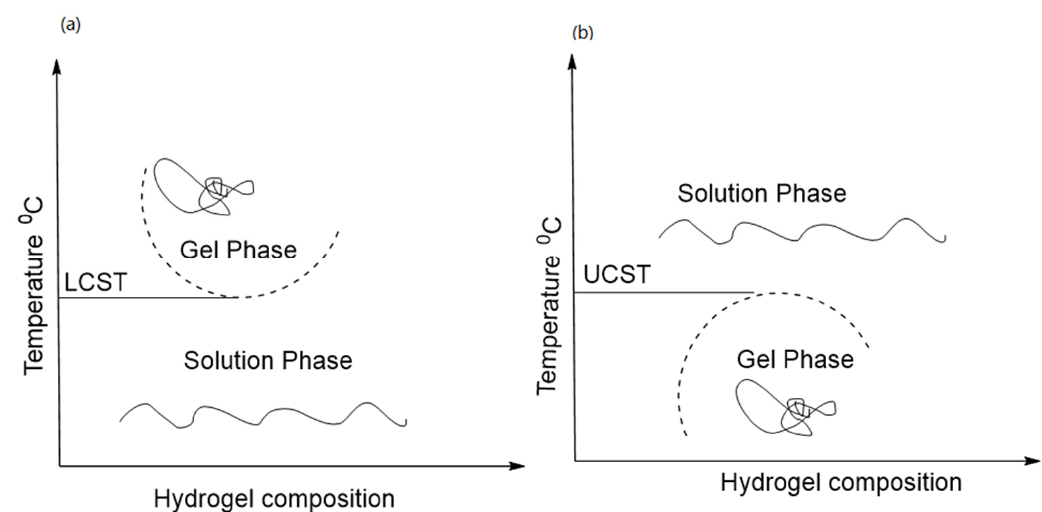
Figure 2. ( a ) the lower critical solution temperature (LCST) formed hydrogel on increasing temperature, and ( b ) the upper critical solution temperature (UCST) formed hydrogel on cooling.